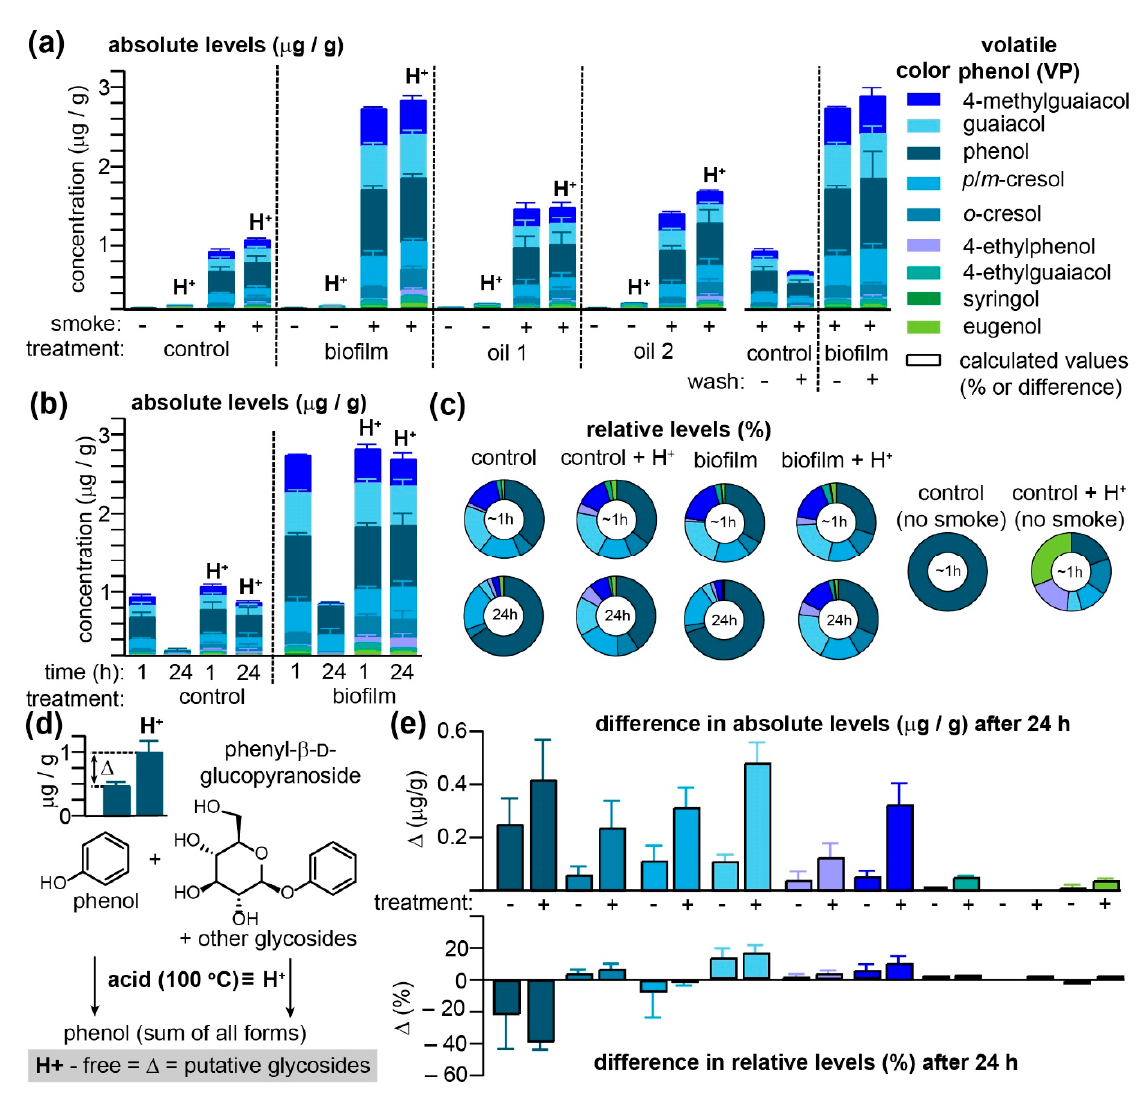
Figure 1. Commercial table grapes are an effective model for evaluating methods to prevent the accumulation of VPs due to smoke exposure. ( a ) Agro-spray treatments 16 h prior to smoke exposures increase the concentrations of VPs present in/on grapes processed and analyzed within one hour of smoke exposure for both untreated and biofilm-treated grapes, VPs could not be rinsed off with water. Histograms labelled with the H + indicate that VPs were quantitated after acid hydrolysis. ( b ) Then 24 h after smoke exposure, both untreated and biofilm-treated table grapes had transformed significant quantities of free VPs into acid-labile conjugates, albeit ( c ) relative levels of free VPs were altered over this time period. ( d ) The difference between free and acid-labile VPs represents the fraction putatively glycosylated in-grape, illustrated here with phenol. ( e ) Differences in total (i.e., the sum of bound and free VPs) and free VPs 24 h post-smoke exposure indicate in-grape transformation; histograms depicting the difference in VP levels ( Δ ) are indicated with a black outline. Error bars for histograms indicate the standard error of the mean (SEM) for n = 3 replicate bunches of grapes except for ( e ), where they denote the quadrature-sum of the SEM.